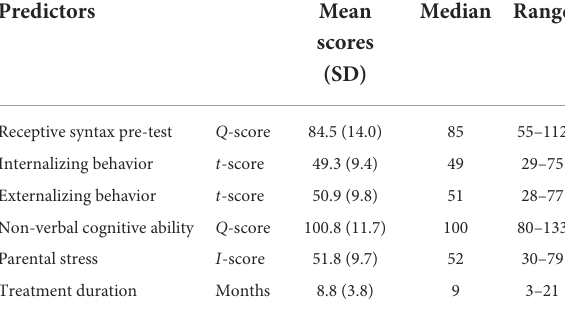
TABLE 2 Mean scores, medians and ranges of continuous